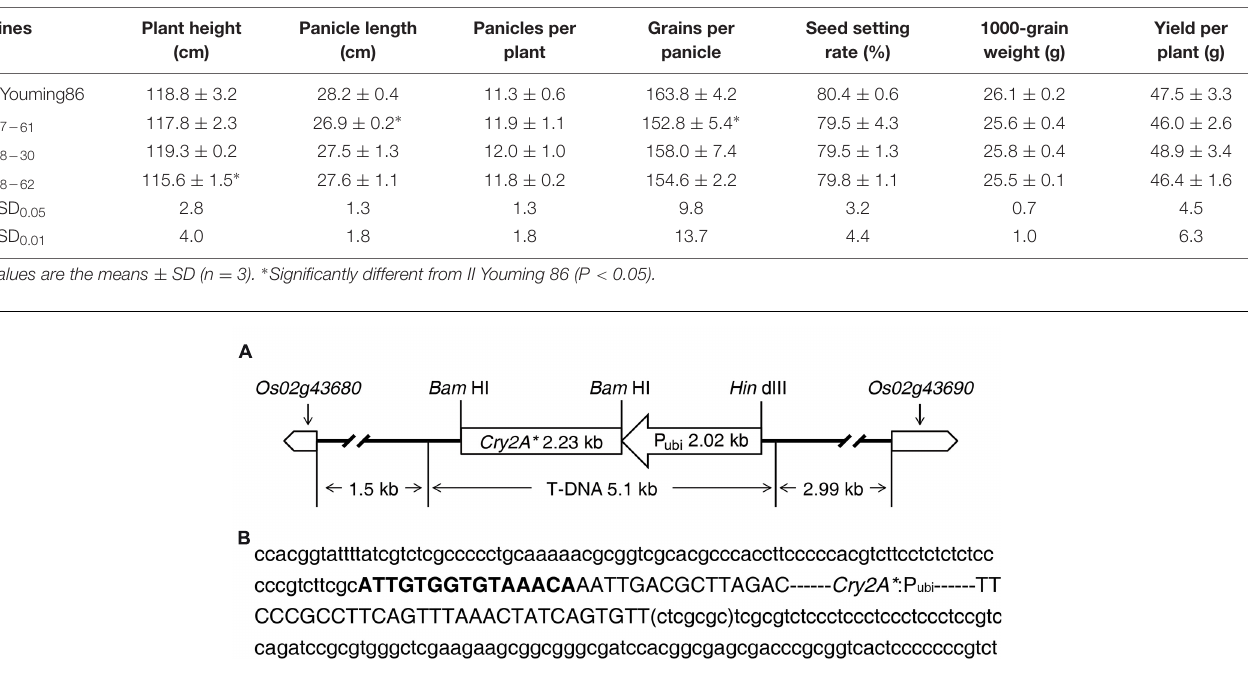
Panicle length Panicles per (cm) (cm) plant